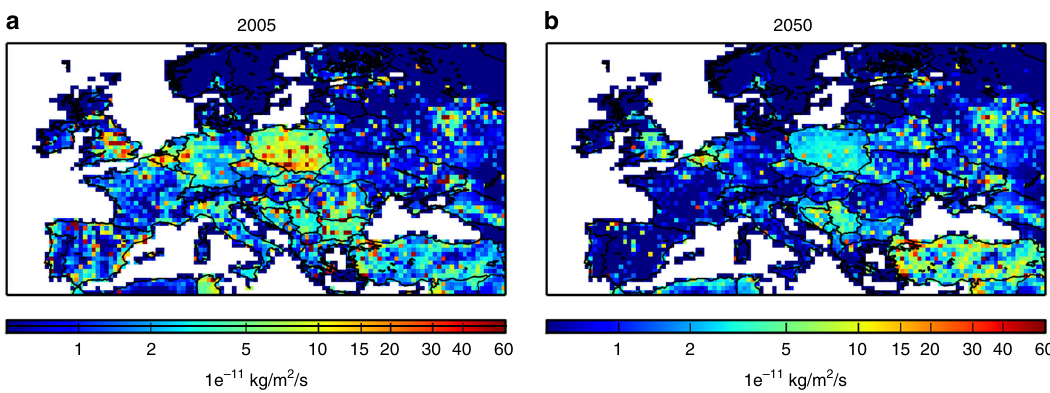
Fig. 5 Evolution of ECLIPSE-V4a SO x emissions between 2005 and 2050. ECLIPSE-v4a SO x emissions in a 2005 and b in 2050. Units are 1e − 11 kg/m 2 /s. This fi gure has been generated using the Matplotlib library for the Python programming language (https://matplotlib.org/)